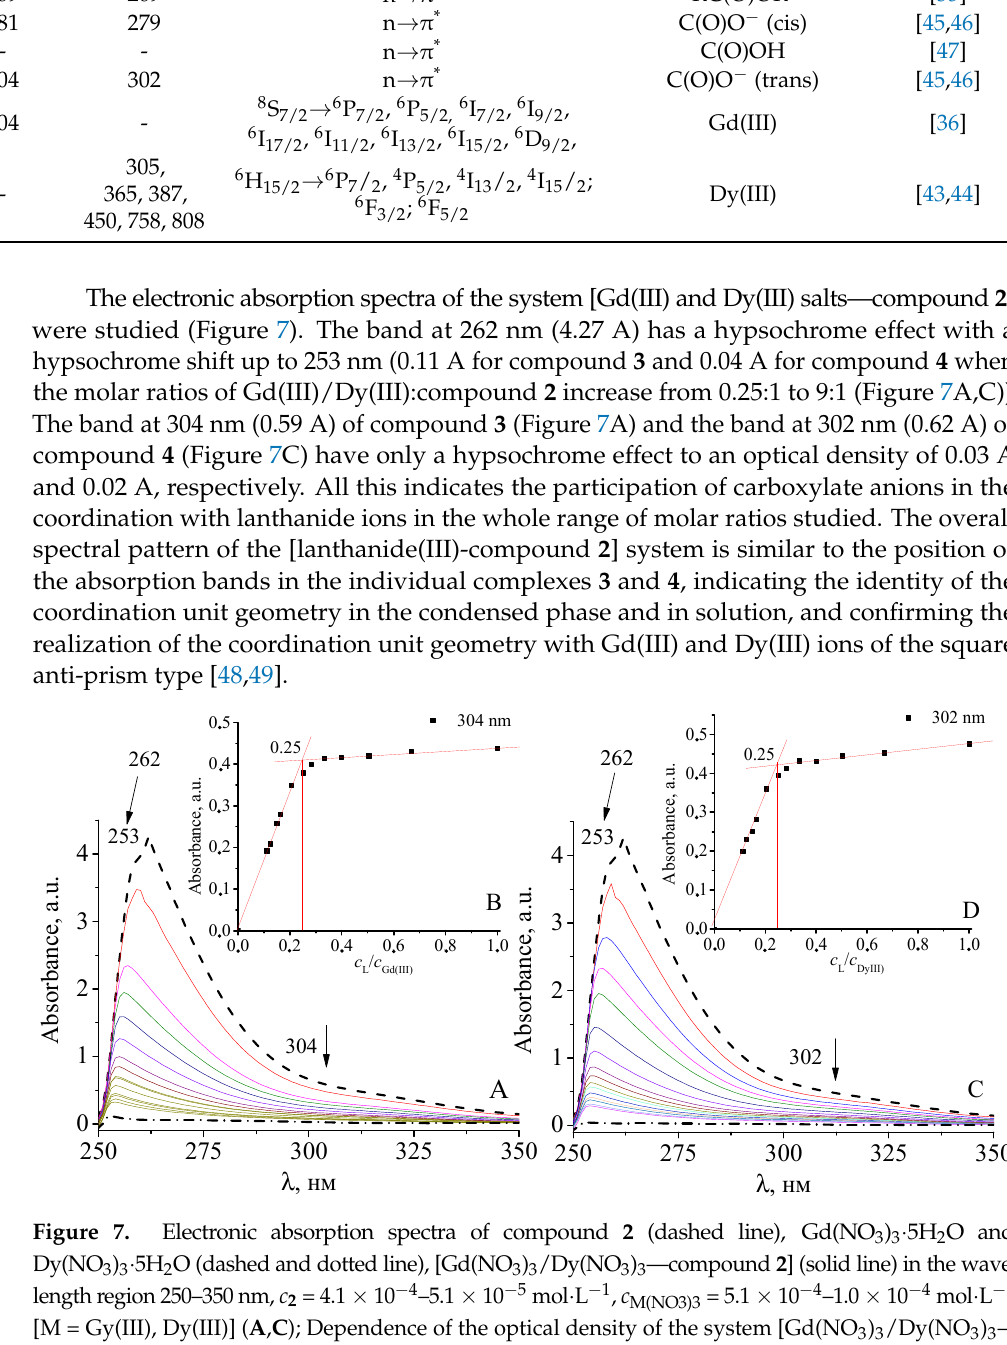
Band, Bond and Metal